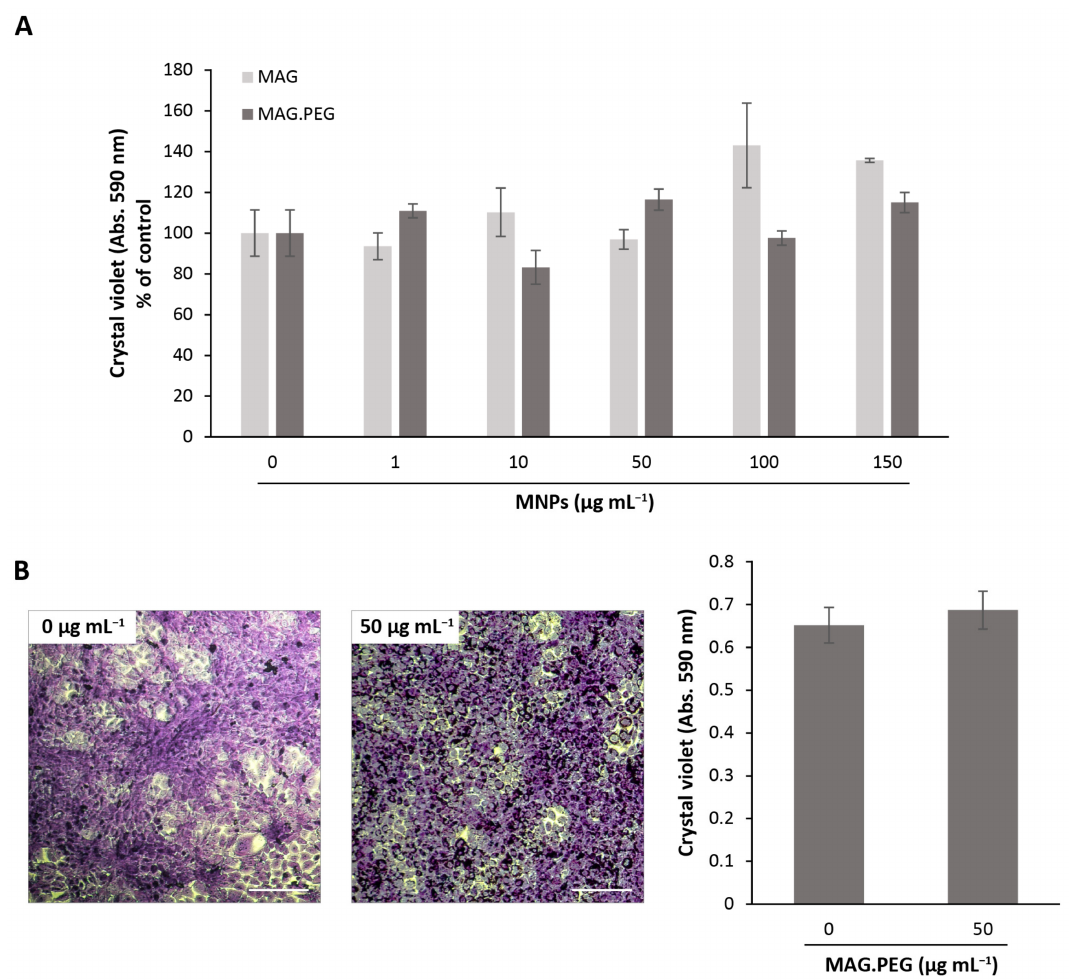
Figure 3. Cell proliferation analysis . The vGPCR cells were incubated with different concentrations of MNPs (1–150 µ g mL − 1 ) or distilled water as control for 48 h ( A ) or in the presence/absence of MAG.PEG (50 µ g mL − 1 ) for 120 h ( B ). To determine the proliferation, the cells were stained with crystal violet and thereafter the colorant was quantified at 590 nm. ( A ) The data is presented as the percentage of control ± SD. Non-statistically significant differences were assessed by Kruskal–Wallis test. N = 3. ( B ) Representative micrographs were obtained by an inverted light field microscope. Scale bar = 50 µ m. Magnification 100 × . Absorbance data is presented as mean ± SD.